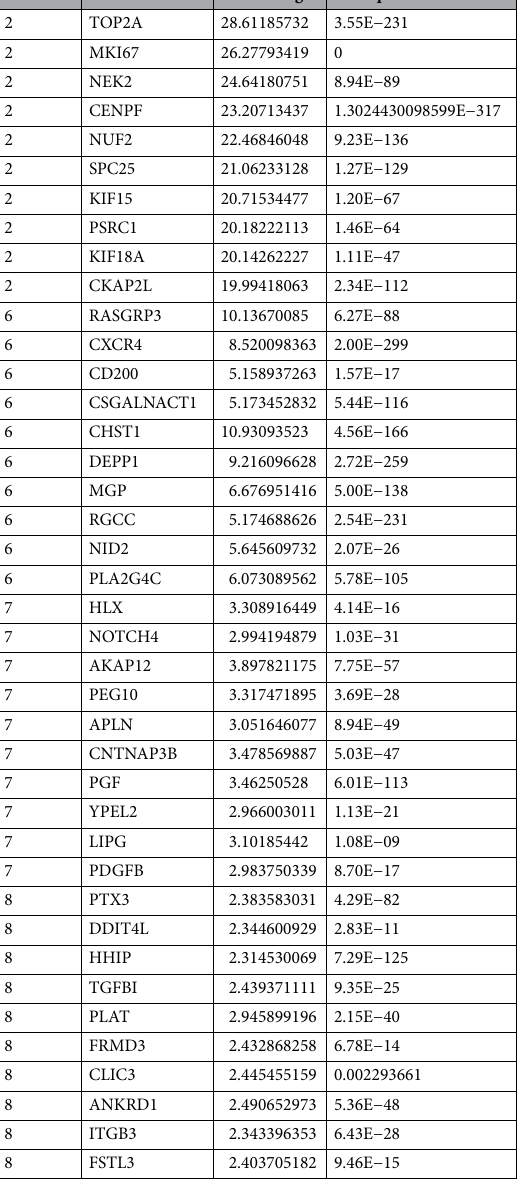
Table 2. Top ten upregulated genes in control clusters. Clusters 1 and 3–5 among control PAEC exhibited mostly down-regulated genes. The set of top ten overexpressed genes in control 2 cluster was enriched in genes involving cell proliferation, including cenpf, ckap2l, kif15, kif18a, mik67, nek2 and spc25. Control cluster 6 had increased expression of top ten genes regulating immune cell—endothelial interaction and new vessel formation such as cd200, Carbohydrate Sulfotransferase 1 ( chst1 ), cxcr4, matrix Gla protein ( mgp ) , and Ras guanyl-releasing protein 3 ( rasgrp3 ). Sprouting and migratory gene signatures, A-kinase anchoring protein 12 ( akap12 ), aplin ( apln ) , H2. 0 Like Homeobox ( hlx ), Neurogenic locus notch homolog 4 ( notch4 ), and pdgfb were enriched in control cluster 7. Highly expressed genes in control cluster 8 were characteristic of inflammation and angiogenesis, including fstl3, hhip, itgb3, ptx3 and